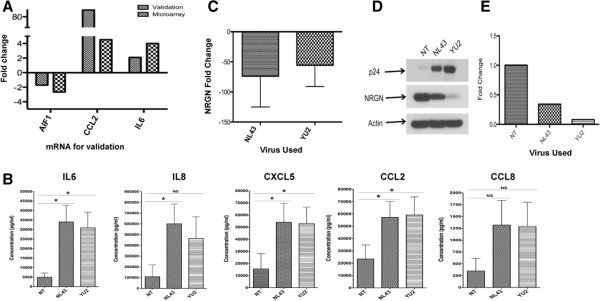
Validation of HIV-1 regulated host cellular factors at the RNA and protein level. (A) Independent validations of randomly selected differentially regulated mRNAs from transcriptome analyses. qRT-PCR was performed to validate the expression of selected mRNAs using specific primer and probe pairs. Fold increase/decrease was calculated based on normalization to RPLPO. Average fold change for each mRNA represents fold change obtained from independent donors (N = 5 per group). (B) Inflammatory factors released by HIV-1 infected PBMC compared to uninfected control cells. Expression of CCL2, CCL8, CXCL5, IL6 and IL8 was monitored by ELISA in supernatants obtained from PBMCs infected with CXCR4-coreceptor utilizing virus (NL43), CCR5-coreceptor utilizing virus (YU2) or mock infected PBMCs (n = 7). * = p < 0.05; NS, Not significant. (C) Expression level of NRGN transcript in PBMCs infected with NL43, YU2 or mock infected cells. Post infection, RNA was isolated and qRT-PCR was performed using NRGN specific primers and probe and results were normalized to RPLPO control. Fold change was calculated using uninfected/mock infected PBMC controls. (D) Immunoblot of NRGN to measure the protein level in PBMC infected with HIV-1 virus or mock. Gag-p24, represents infectivity; and Actin, represents loading control. (E) Densitometry was performed to quantitate the fold change in signal intensity compared to uninfected (NT) and normalized with Actin level. NT, uninfected control; NL4-3, CXCR4 coreceptor virus; and YU2, CCR5 coreceptor virus.